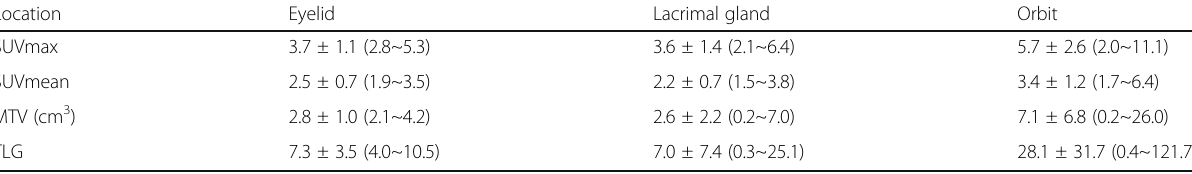
Table 2 The mean ± standard deviation and range of PET parameters according to the location of lymphoma